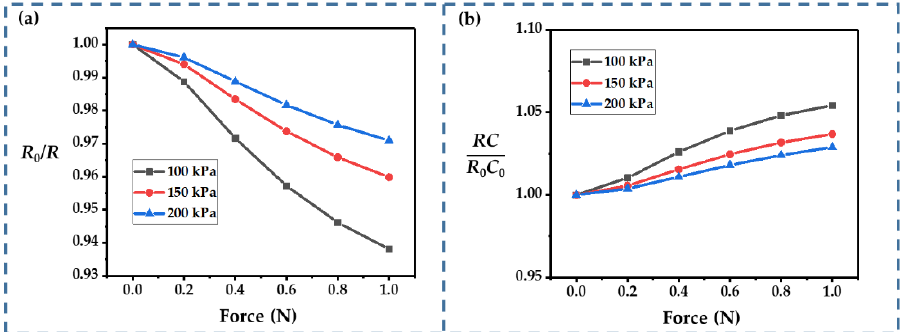
Figure 10. Influences of Young ’ s modulus of the electrolyte film on ( a ) R 0 / R and ( b ) RC / R 0 C 0 .